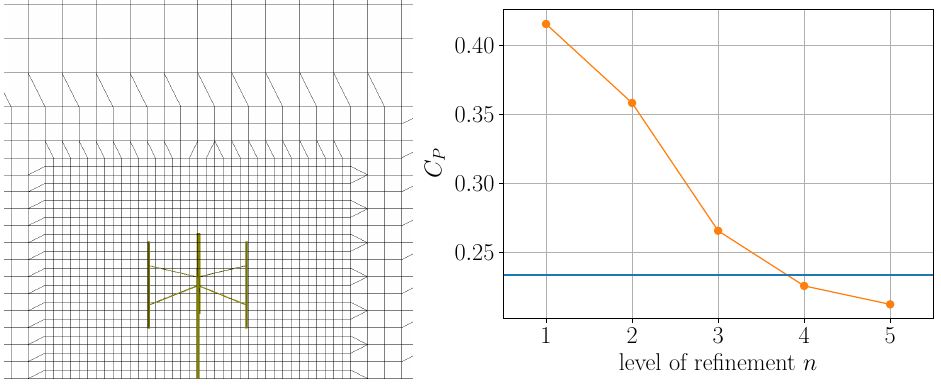
Figure 4. Example illustration of the reference mesh section with a local refinement level of n = 2 ( left ) and the power coefficient response at λ = 4.02 for mesh variation using different level of refinement ( right ). The horizontal blue line represents the experimental value for the tested λ